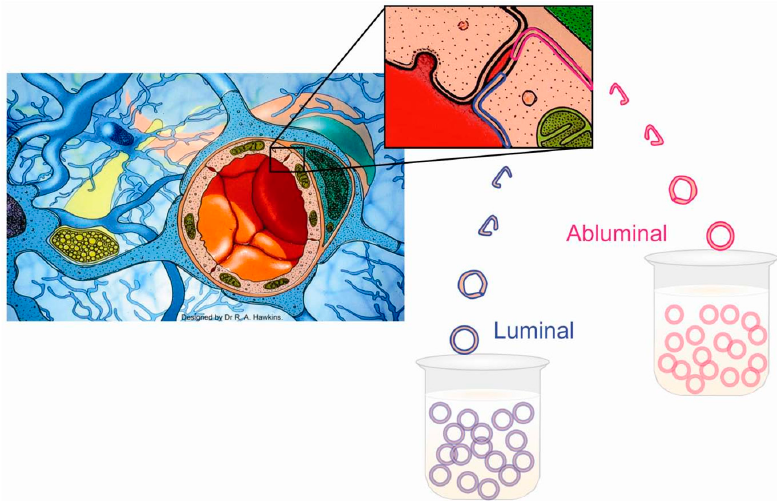
Figure 1. Diagrammatic representation of the blood–brain barrier and isolated luminal and abluminal membranes. The BBB exists at the level of the endothelial cells of cerebral capillaries. The endothelial cells are joined together by an extensive network of tight junctions. A basement membrane, within which pericytes reside, surrounds the endothelial cells, as does a layer comprised of astrocyte processes (so called end ‐ feet). The pericytes are numerous and most likely function as phagocytes. The astrocyte layer serves as a metabolic barrier. For instance, astrocytes incorporate NH 4+ into glutamine, and metabolize short ‐ chain fatty acids. Capillaries are collected from the bovine cerebral cortex, and their membranes detached [17,18]. The luminal and abluminal membranes are isolated by differential centrifugation. The membranes form sealed spheres that are suitable for the study of transport. It is possible, for instance, to create trans-membrane potentials, and establish external Na + gradients testing for the presence of Na + -dependent transport systems. This illustration is modified from a figure in